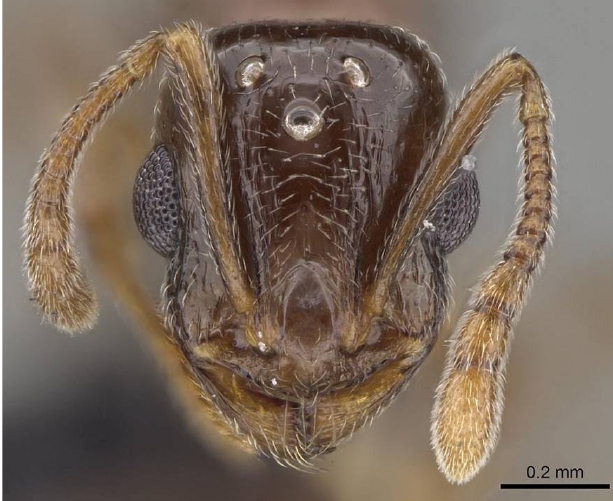
Fig 7 . Head of Temnothorax ansei sp.n. queen in frontal view. Photo credit: Michele Esposito, from www.AntWeb.org,CASENT